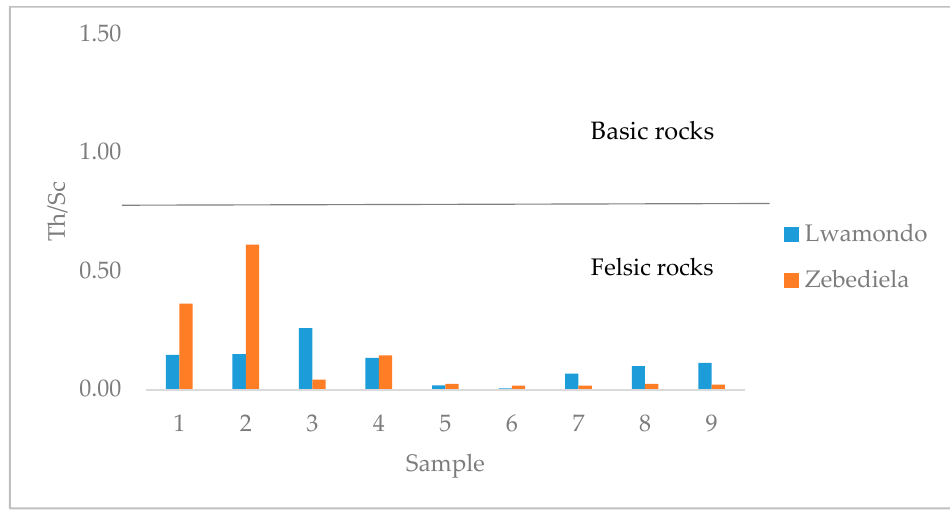
Figure 9. Plot of Th/Sc of the Lwamondo and Zebediela kaolins, showing a silicic source. Minerals 2019 , 9 , 93